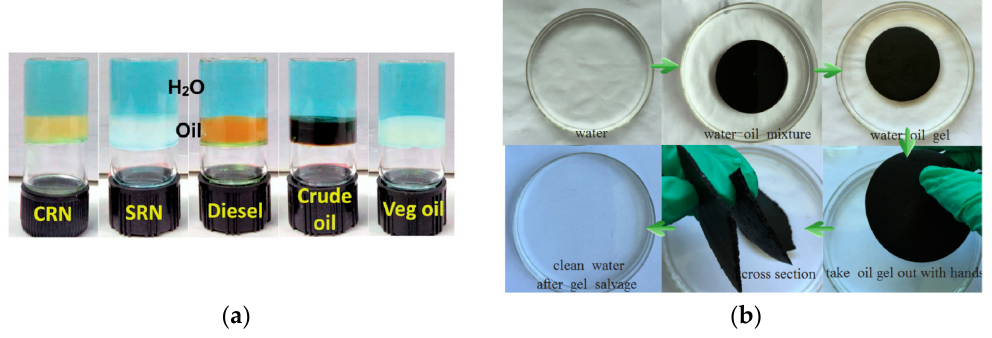
Figure 15. Supramolecular gels have been designed for the highly selective separation of crude oil products from water. ( a ) The separation of several oils from water with a xylitol-based organogelator by Raju et al. [141] Adapted with permission from ref [141]. Copyright Year Copyright Owner’s Name. ( b ) The segregation and removal of Russian crude oil from water using an alkyl bicarbamate supramolecular gel by Wang et al. [140]. Adapted with permission from ref [140]. Copyright 2017 Elsevier.